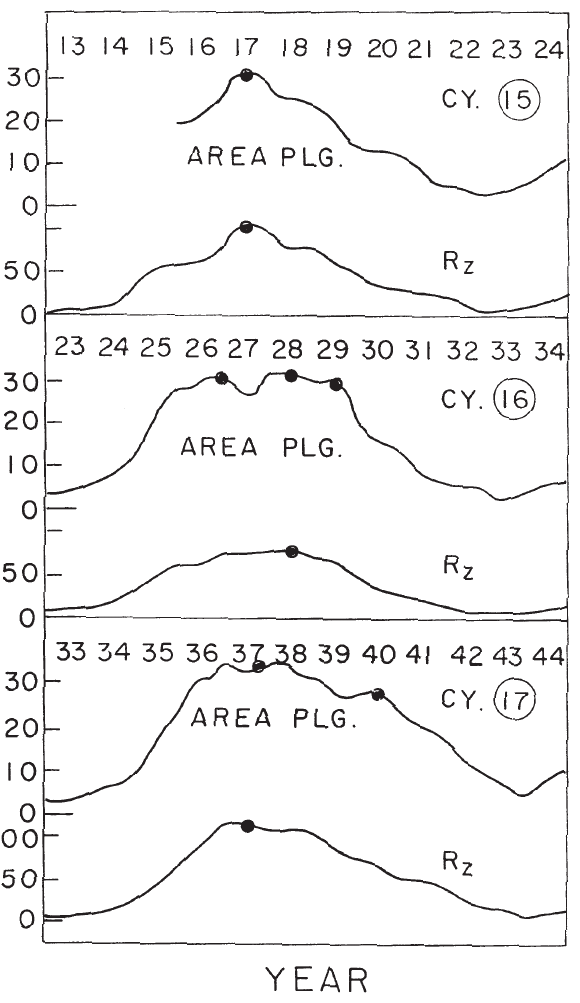
Fig. 3. Plots of smoothed sunspot number Rz and the Ca Plage Area, for cycles 15, 16, 17. The full dots indicate maxima.